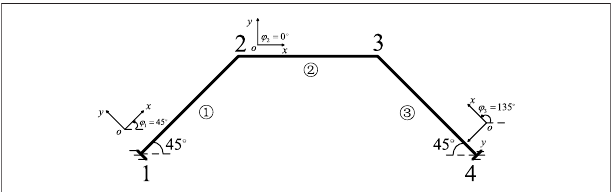
FIGURE 5 | Node coding (point i to point j